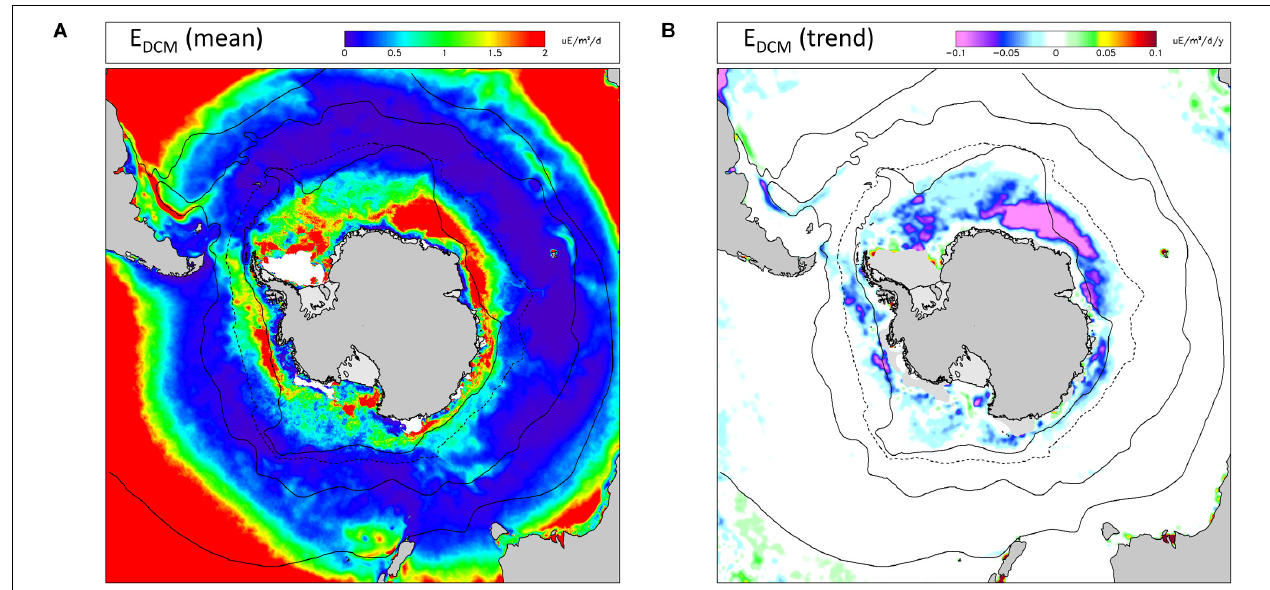
FIGURE 6 | Irradiance at the base of the mixed layer (E DCM ) as a proxy for potential primary production in the deep chlorophyll maximum (DCM). (A) long-term (1997-2019) mean values; (B) linear trends (Sen slopes) over the same period. Other information as Figure 2 .